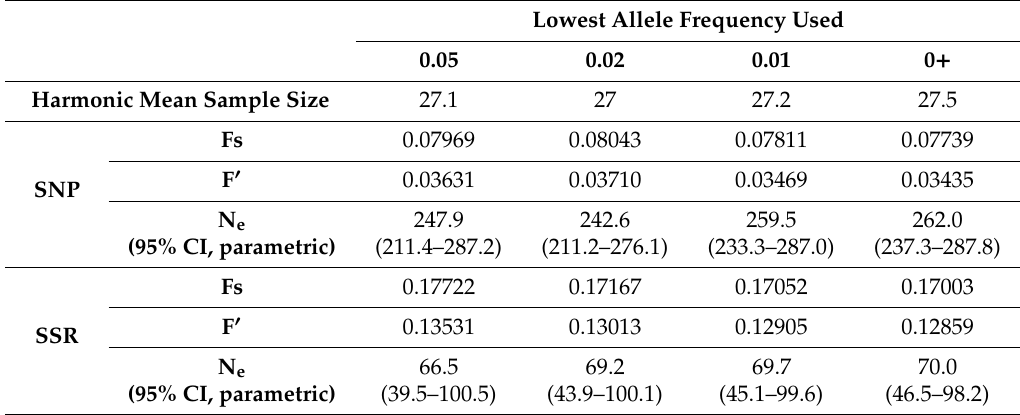
Table 4. N e estimates based on SNP and microsatellite (SSR) data (Jorde and Ryman method [57]). Lowest Allele Frequency Used 0.05 0.02